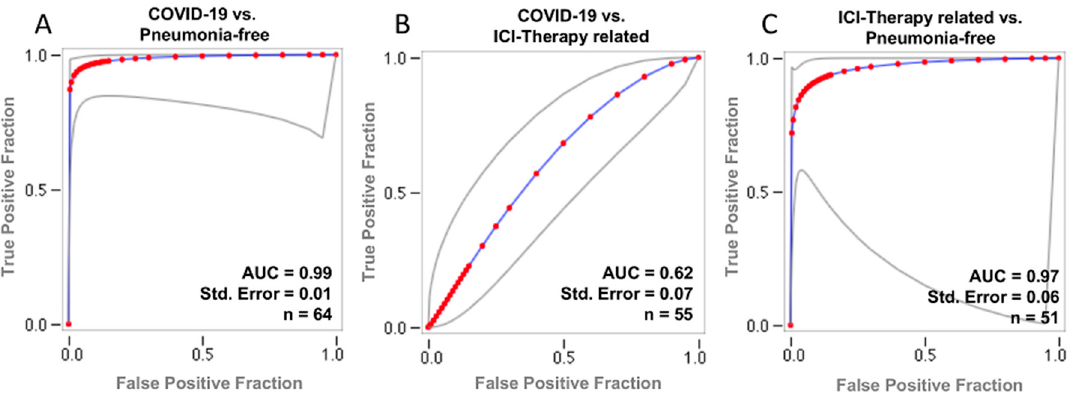
Figure 2. Receiving operating curves (ROC) of the diagnostic performance of the AI prediction risk of COVID-19 pneumonia. Each plot shows the ROC obtained during testing after including the pairs: COVID-19 and pneumonia-free patients ( A ), COVID-19 and ICI-related therapy ( B ) and ICI-related therapy, and pneumonia-free patients ( C ). Gray lines plot 95% confidence intervals. COVID-19 = coronavirus disease 2019. ICI = immune checkpoint inhibitor. AUC = area under ROC. Std. Error = standard